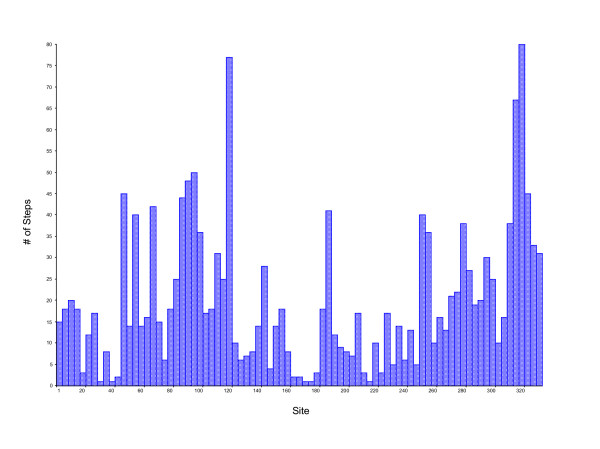
Pattern of amino acid substitution in the coding regions of the plant GSK proteins based on the comparison of 116 sequences. The x-axis (site) was constructed based on 4-aa intervals.